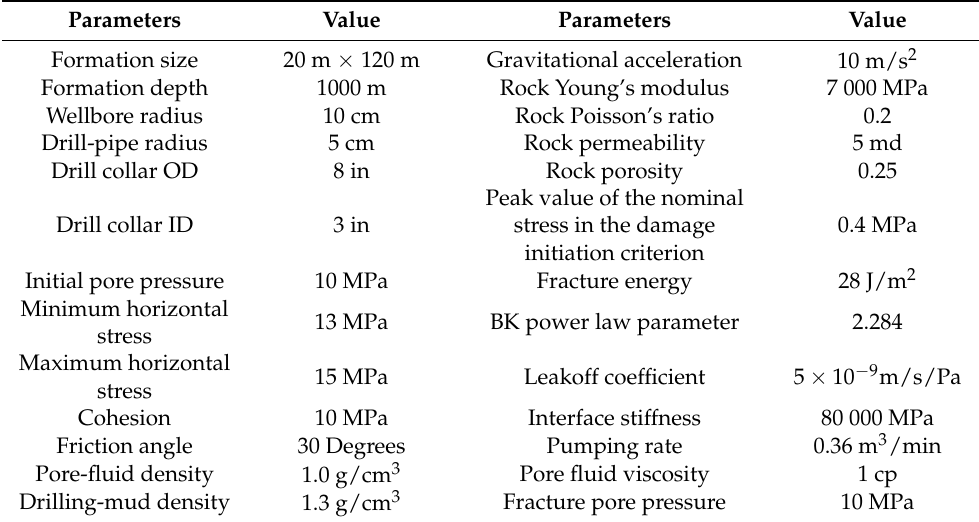
Table 1. Input parameters for base case